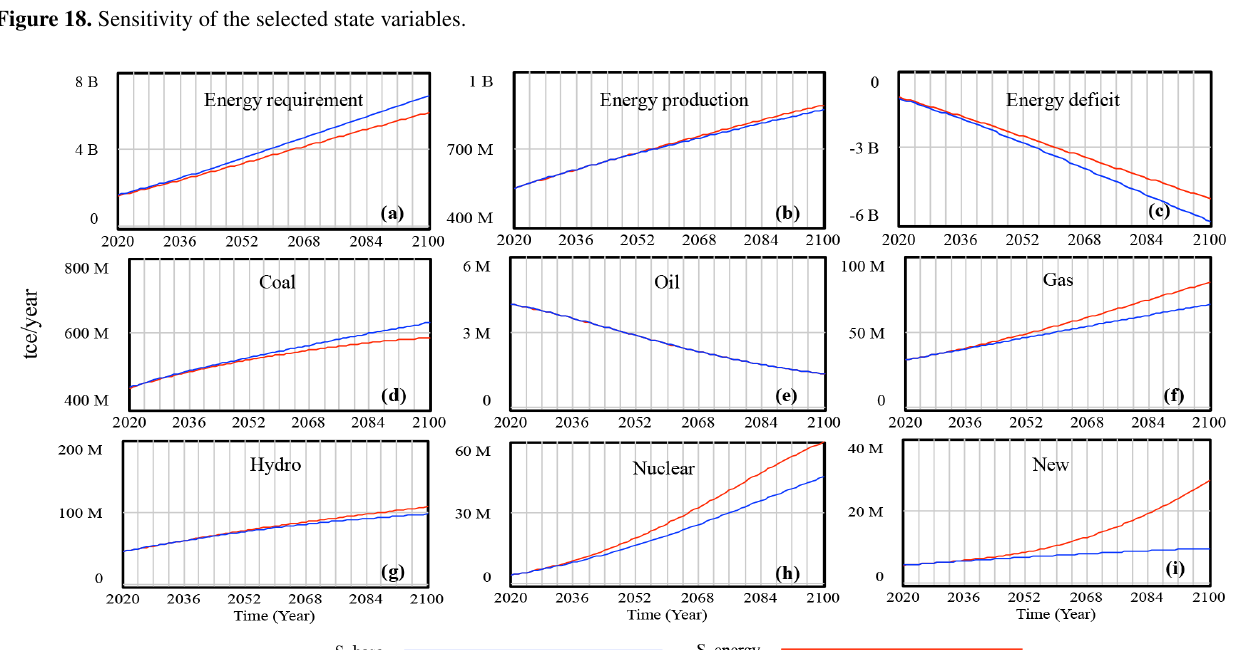
Figure 19. Effects of energy policy on the energy